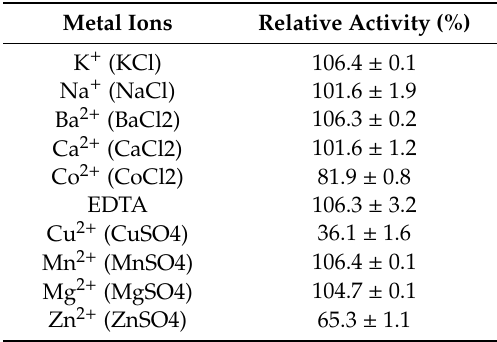
Table 1. E ff ect of metal ions on chitinase 1198